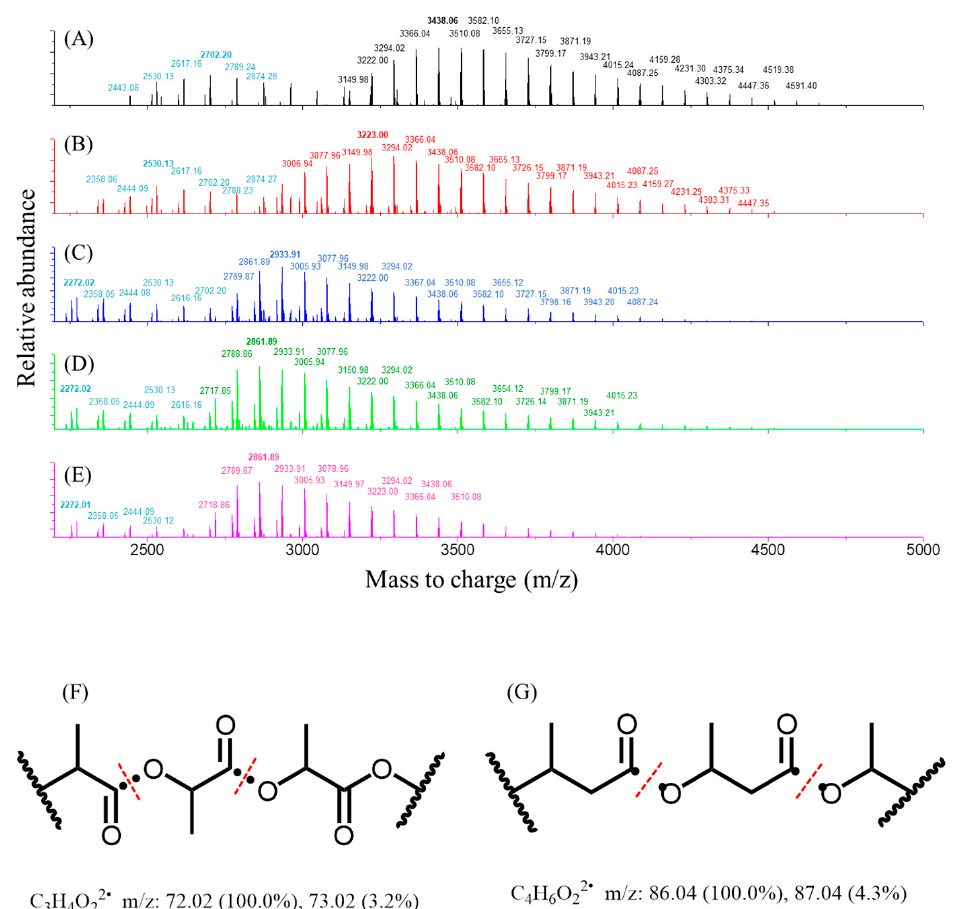
Figure 11. Electrospray ionization mass spectra (ESI-MS) of ( A ) fresh, blank PLA/PHB fabrics and PLA/PHB fabrics under multiple environmental parameters, including ( B ) static seawater, ( C ) aerated seawater, ( D ) UV-lighting static seawater, and ( E ) UV-lighting aerated seawater. ( F ) The MS fragmentation analysis of PLA polymer and ( G ) the MS fragmentation analysis of PHB polymer.